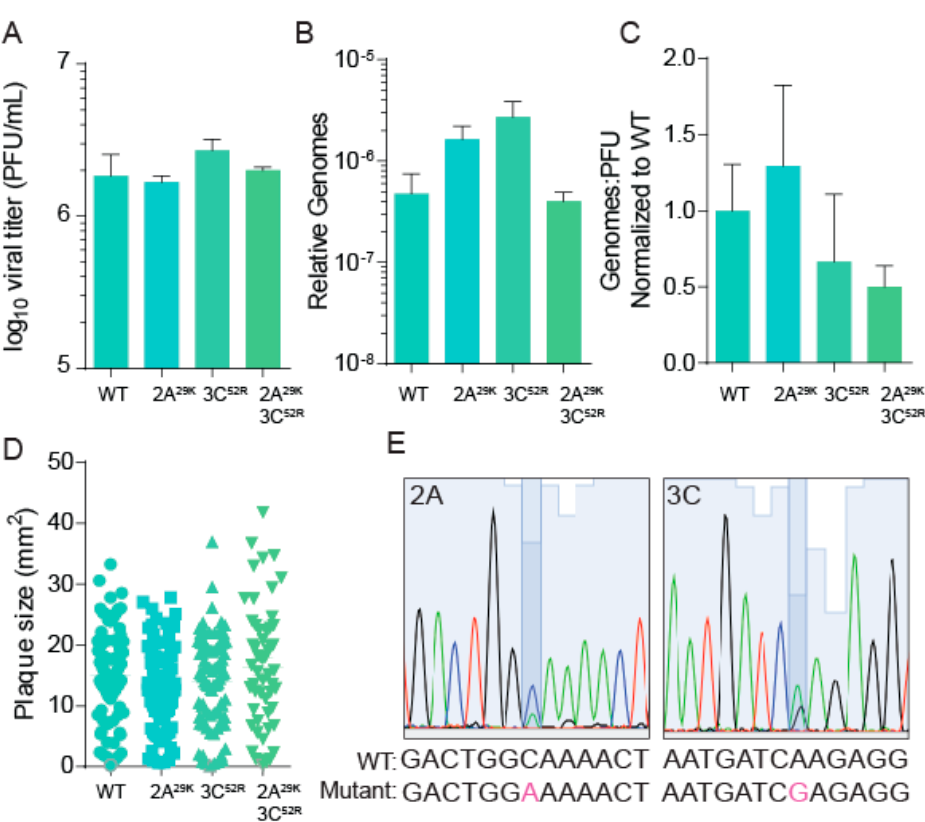
Figure 3. CVB3 stability, fitness, and specific infectivity are not altered with protease mutation. Vero cells were infected with wildtype and mutant CVB3 for 24 h, at which time ( A ) viral titers were determined by plaque assay and ( B ) viral genomes in cell supernatant were determined by qPCR. ( C ) The ratio of genomes-to-PFU was calculated by dividing the relative genomes in ( B ) by the titer in ( A ). ( D ) Plaque sizes of virus mutants were determined after a two-day plaque assay. ( E ) WT and mutant CVB3 were used to infect untreated Vero cells for five passages at which time viral RNA was reverse transcribed, PCR amplified and sequenced. Highlighted nucleotide indicates mutant.